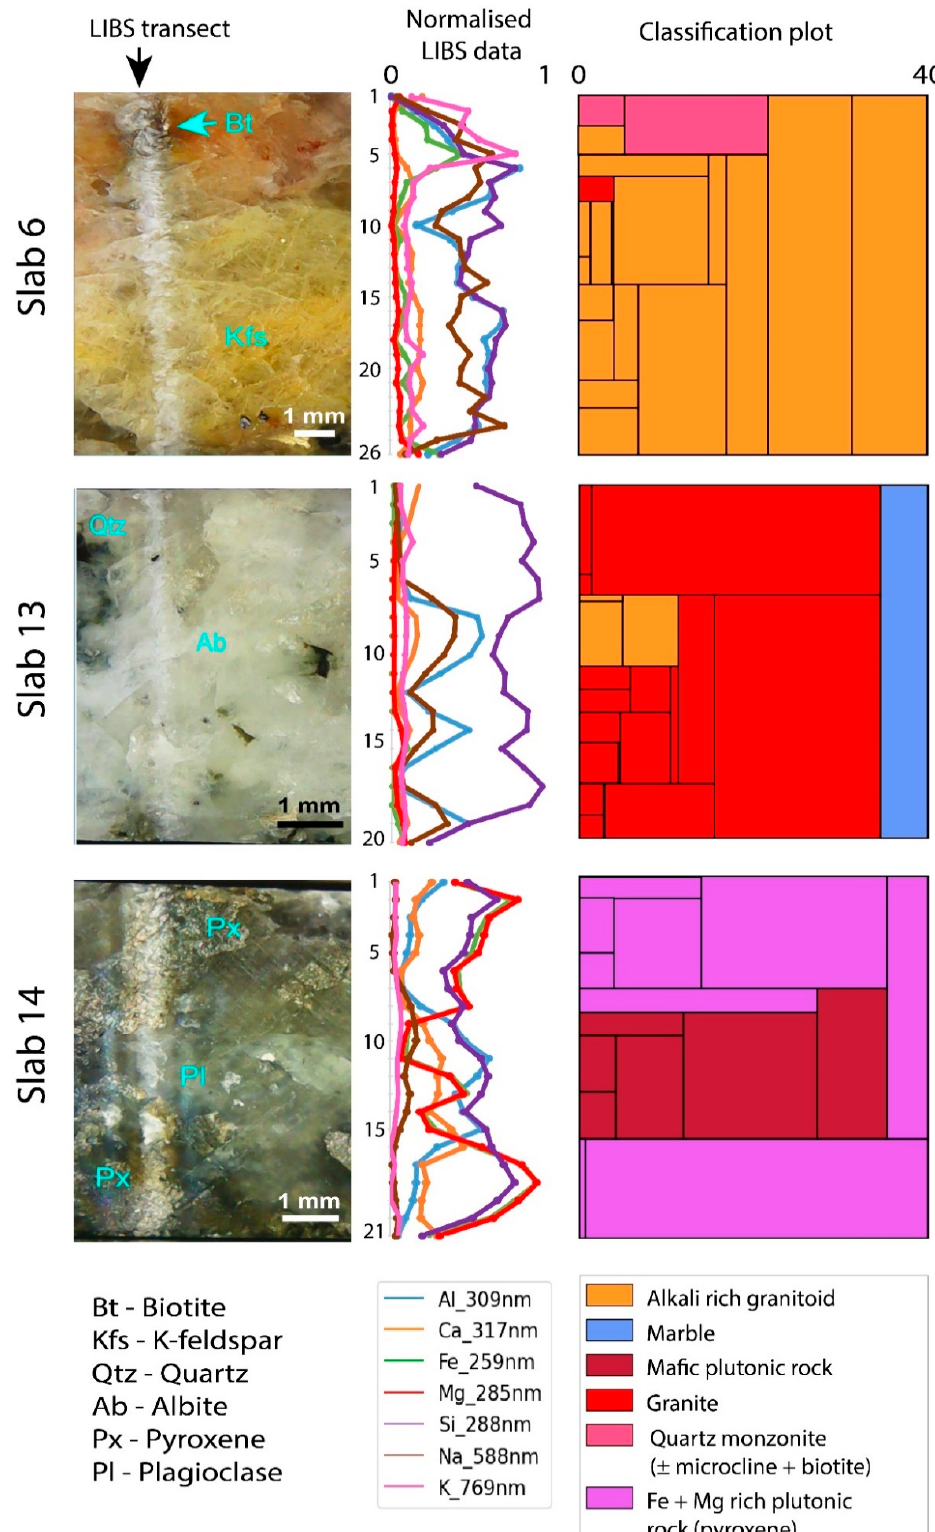
Figure 9. Detailed examination of slabs 6, 13, 14 and their classified data mosaic plots for mineralogical and textural analysis showing the hand specimen ( left ), scaled variables ( middle ) and seven-domain analysis multiscale mosaic classifications for domain scale 0–40 ( right ). LIBS data were normalised from 0 to 1. Each point along the scaled variables represents one LIBS measurement, corresponding to ~0.35 mm